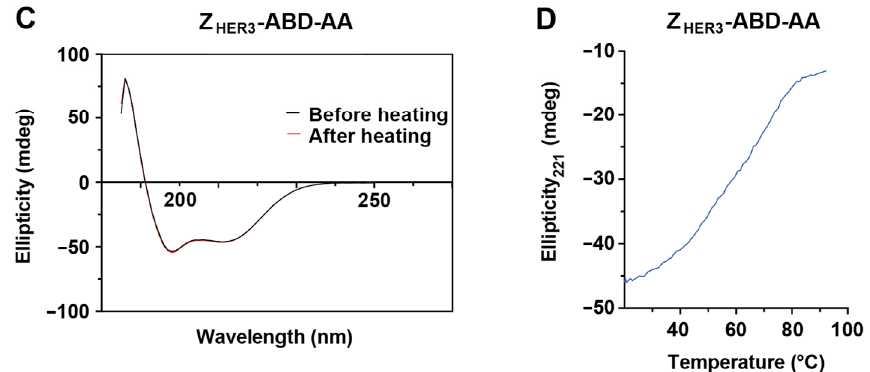
Figure 2. Circular dichroism measurements. Panels ( A , C ) show the measured ellipticity ( y -axis) at different wavelengths ( x -axis). In both panels the spectra obtained before and after heat-induced denaturation followed by refolding are included. The ellipticity at 221 nM was also measured as a function of temperature (Panel ( B , D )). The secondary structure of the constructs is to a large extent alphahelical and the ellipticity at 221 nm is therefore a measurement of the folded state of the constructs.